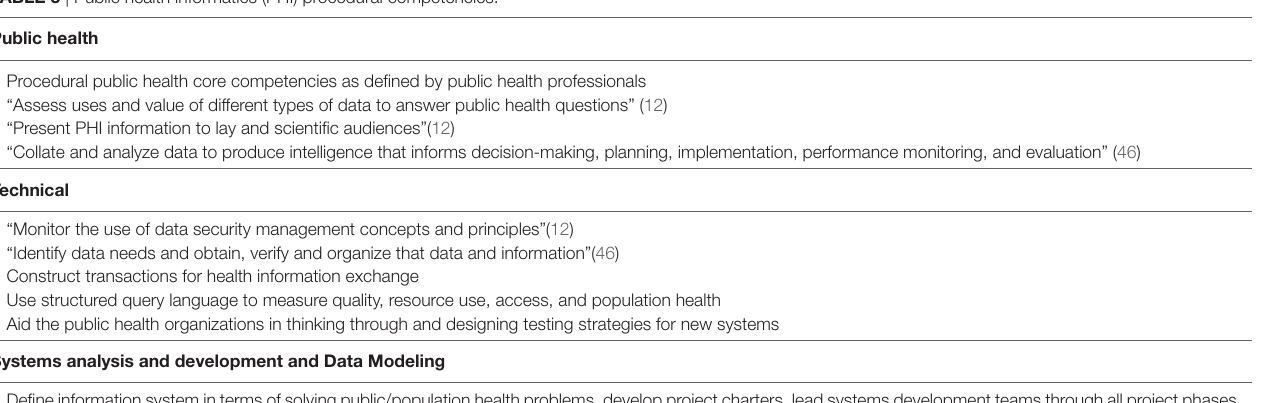
taBle 3 | Public health informatics (PHI) procedural